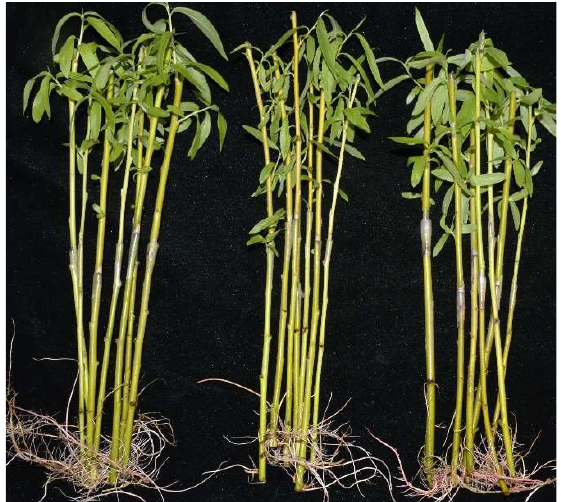
Figure 1. Rooting of the willow grafts 9901/9901, YJ/YJ, and 9901/YJ.